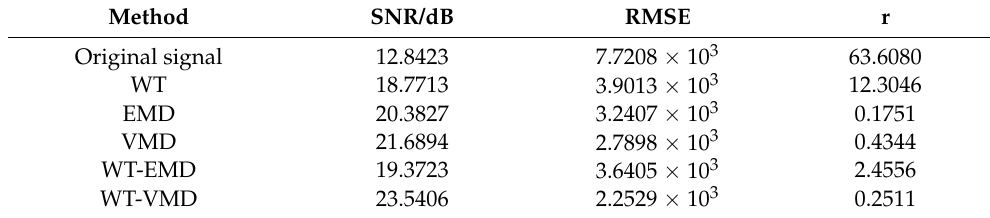
Table 4. Evaluation index of 50-pulse cumulative signal (with aerosol and clouds) after denoising. Table 6. Evaluation index of 1000-pulse cumulative signal (with aerosol and clouds) after denoising.